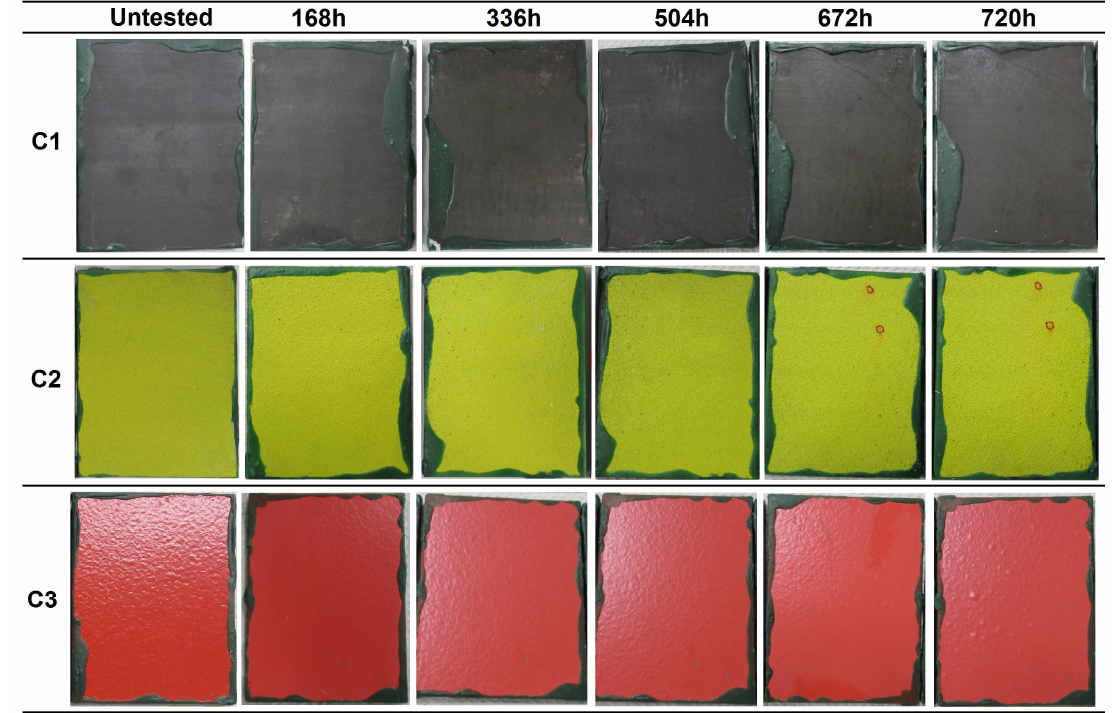
Figure 5. Visual appearance of the coatings’ surfaces at different evaluations during the condensation tests at constant humidity (CH) according to the ISO 6270-2 standard.